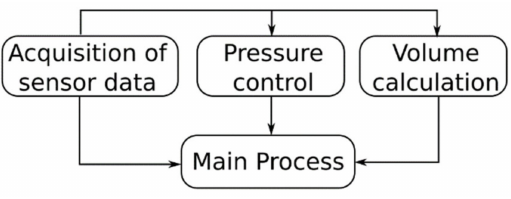
Figure 8. Block diagram of principal